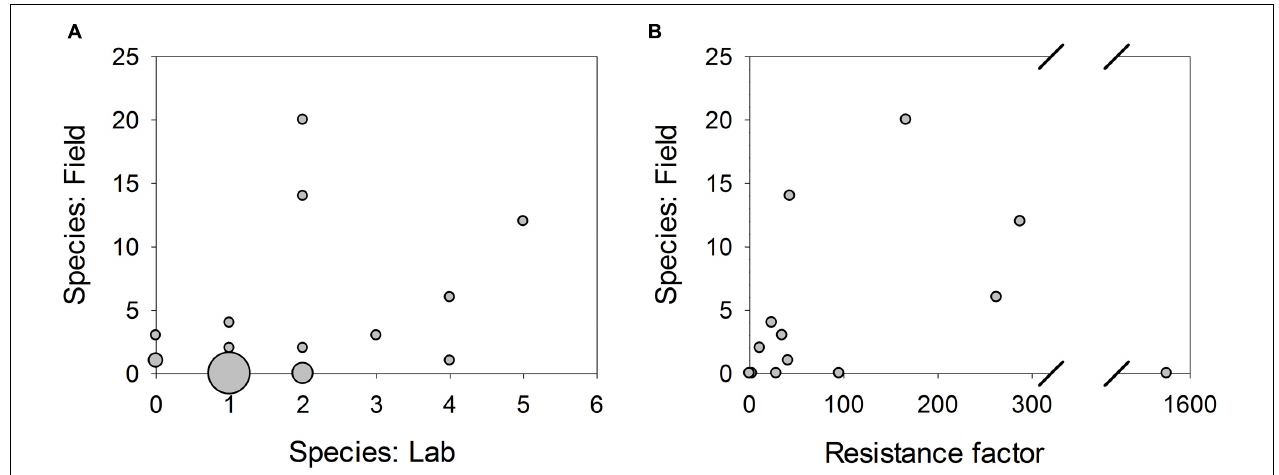
FIGURE 2 | Scatter plots showing the number of species in which a β -tubulin substitution has been reported in MBC-resistant field isolates, against (A) the number of species in which that mutation has been reported in laboratory isolates; (B) the mean resistance factor of mutants with that substitution based on published sensitivity data. Symbol area is proportional to number of